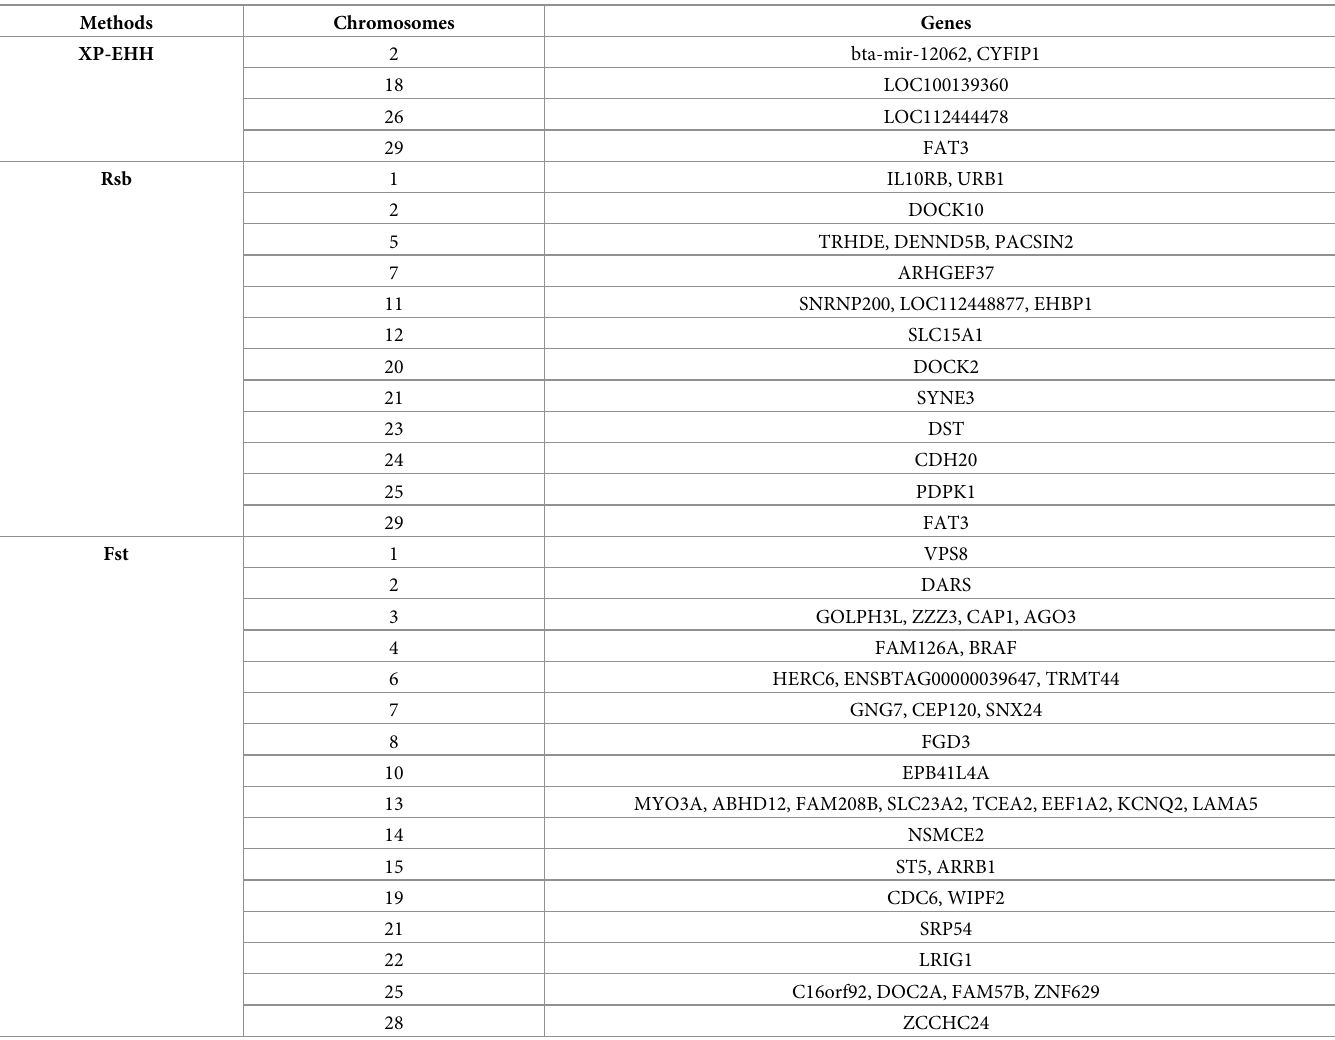
Table 2. Genes located in selection signatures for Canchim vs.